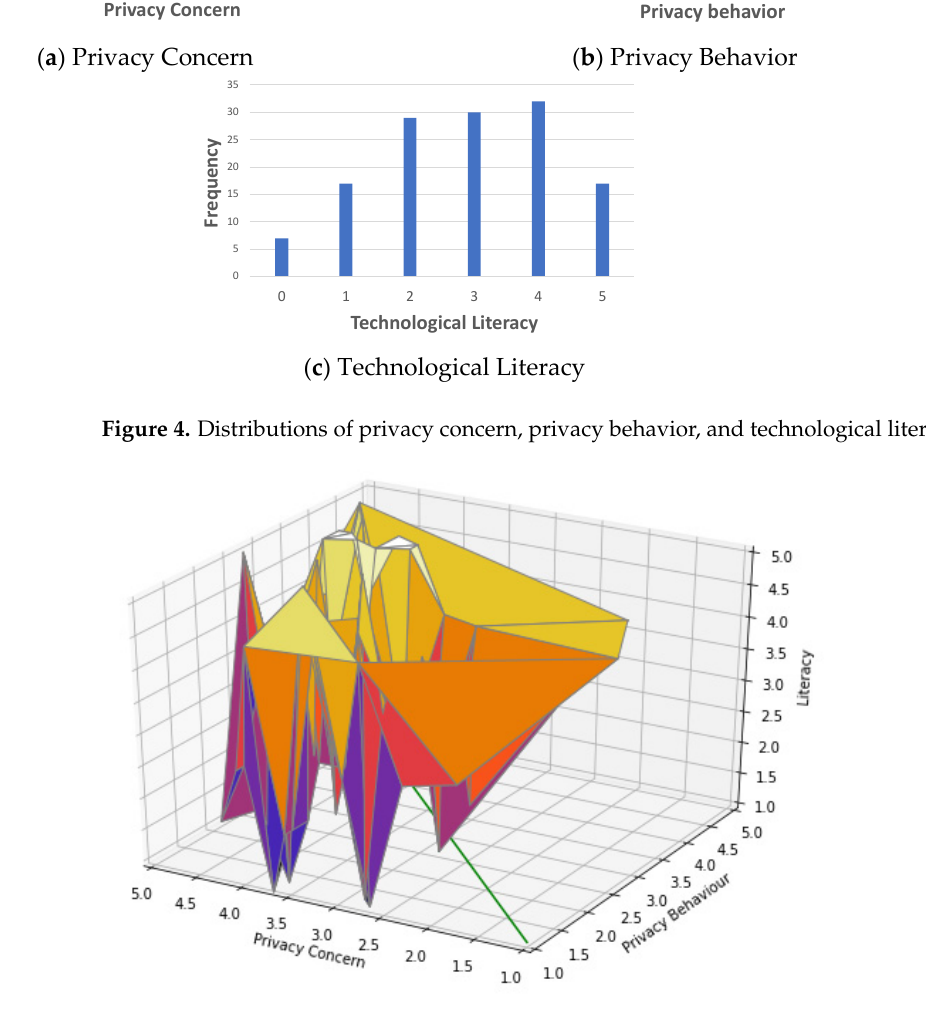
( b ) Representation B ( 𝜓 (cid:2870) ) Figure 6. Graphical representations of the soft numbers yielded by the empirical study.